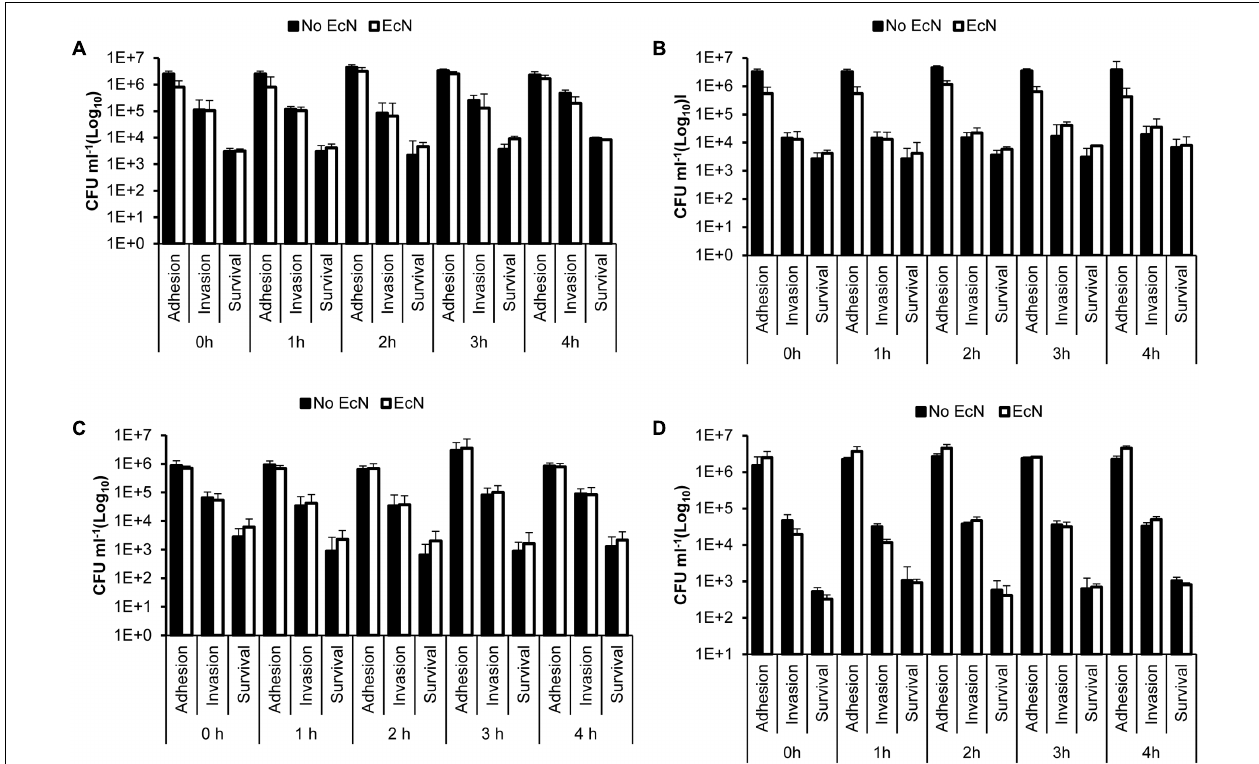
FIGURE 3 | Campylobacter jejuni ’s adhesion to, invasion of and intracellular survival in HT-29 cells following co-incubation of C. jejuni with EcN free supernatant and heat killed cells prior to infection of HT-29 cells. (A) Heat-killed EcN and C. jejuni 81-176 were co-incubated (1:1) for 0, 1, 2, 3, and 4 h at room temperature before the HT-29 cells were infected with the mixture for 2 h. (B) Heat-killed EcN and C. jejuni 81-176 were co-incubated (10:1) for 0, 1, 2, 3, and 4 h at room temperature before the HT-29 cells were infected with the mixture for 2 h. (C) EcN-cell free supernatant and C. jejuni 81-176 were co-incubated for 0, 1, 2, 3, and 4 h at room temperature before the HT-29 cells were infected with the mixture for 2 h. The cell-free supernatant was prepared from cultures containing the same number of EcN CFUs as C. jejuni (1X). (D) EcN-cell free supernatant and C. jejuni 81-176 were co-incubated for 0, 1, 2, 3, and 4 h at room temperature before the HT-29 cells were infected with the mixture for 2 h. The cell-free supernatant was prepared from cultures containing 10X more EcN CFUs than C. jejuni (10X). The experiments were repeated at least two times and samples were processed in four replicates in each